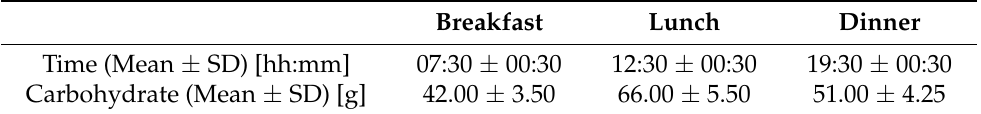
Table 2. Time and amount of carbohydrate of each meal. Breakfast Lunch